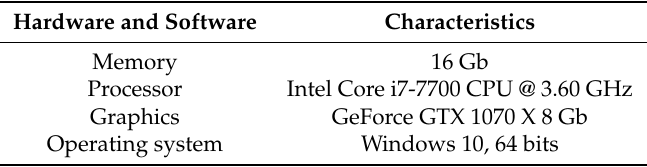
Table 5. Machine